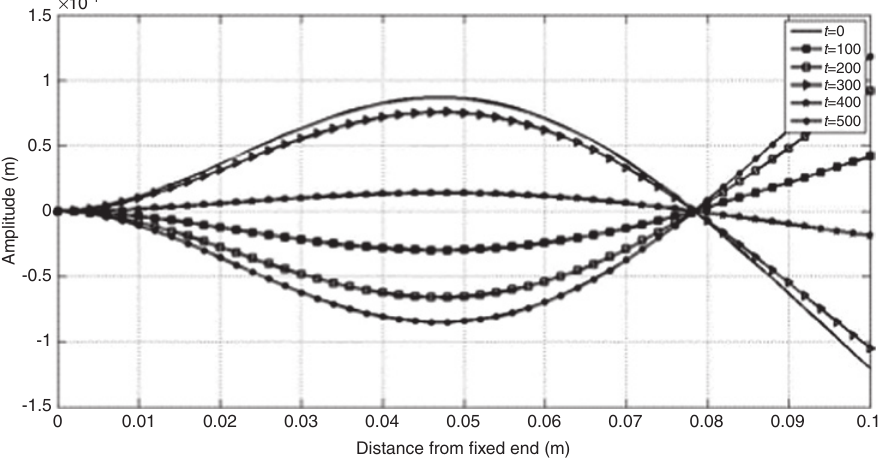
Figure 10: Vibrations of the second characteristic mode of the cantilever beam. Time, t , is in milliseconds.